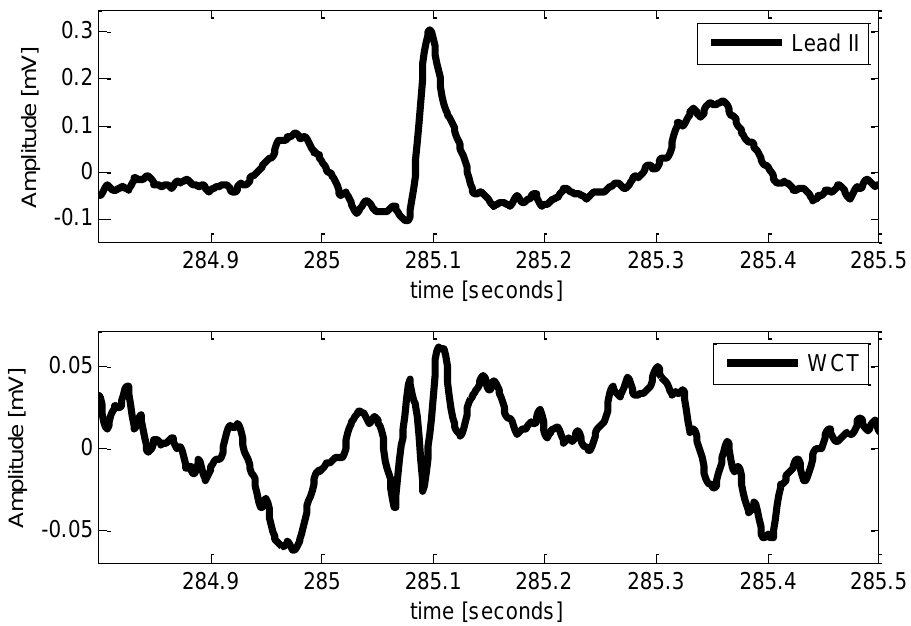
Figure 9. Example of multimodal WCT with evident features in correspondence with “p” and “t” waves. WCT is 23% of lead II amplitude (average); recording is from a 63-year-old female patient admitted from the emergency department with severe chest